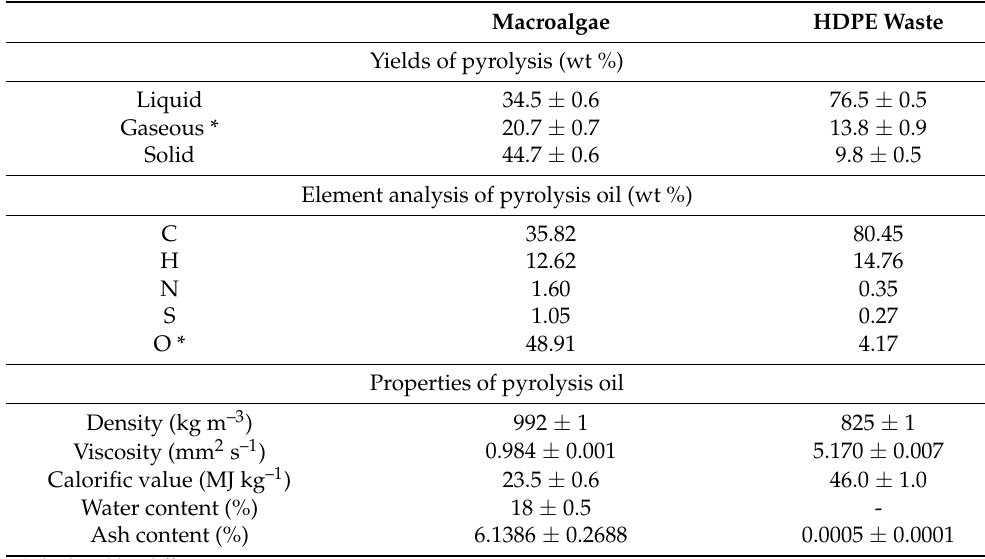
Table 2. Properties of pyrolysis oils from the macroalgae Cladophora glomerata and the HDPE waste at 350 °C.